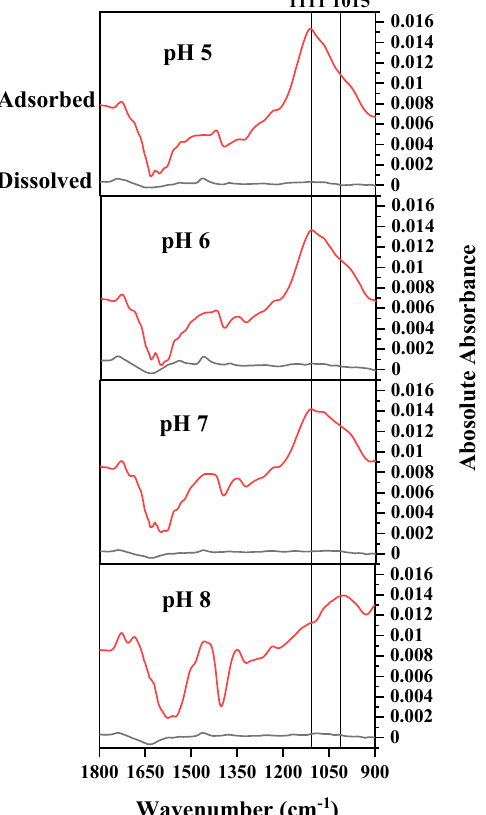
Figure 1. The in situ ATR-FTIR spectra of adsorbed and dissolved Sb (V) were stacked at each pH value. The intensity scale is drawn on actual scale obtained in the experiment.